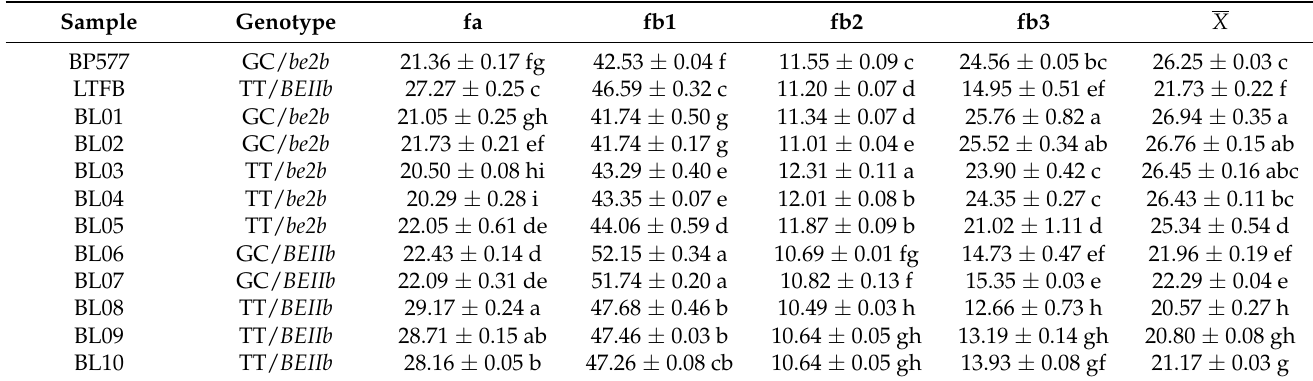
Table 2. Structural parameters of amylopectin CLDs obtained from